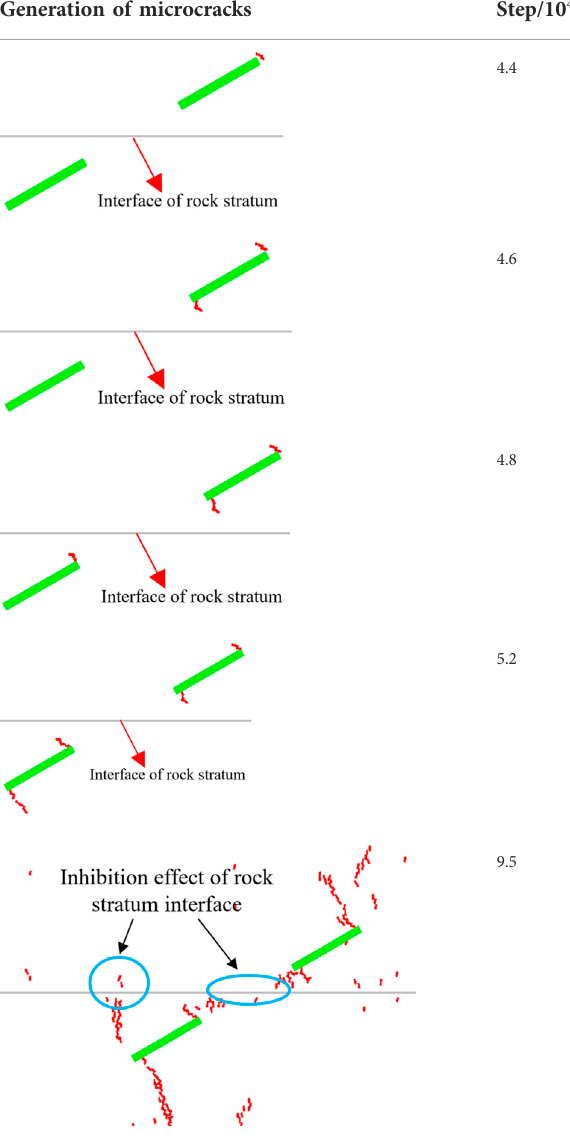
TABLE 7 Schematic of initial microcrack